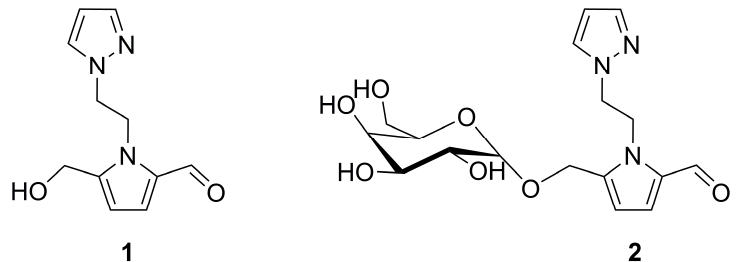
Figure 4. Structure of two pyrazole derivatives 1 and 2 isolated from the seeds of Citrullus lanatus watermelon. 1-[2-(5-hydroxymethyl-1 H -pyrrole-2-carbaldehyde-1-yl)ethyl]-1 H -pyrazole ( 1 ) showed no cytotoxicity, while 1-({[5-(α- D -galactopyranosyloxy)methyl]-1 H -pyrrole-2-carbaldehyde-1-yl}- -ethyl)-1 H -pyrazole ( 2 ) was mildly cytotoxic on mouse melanoma cells.